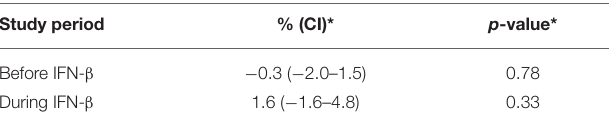
TABLE 3 | Change in serum NfL concentration with every 10 nmol/L increase of 25(OH)D when controlling for MRI disease activity. Study